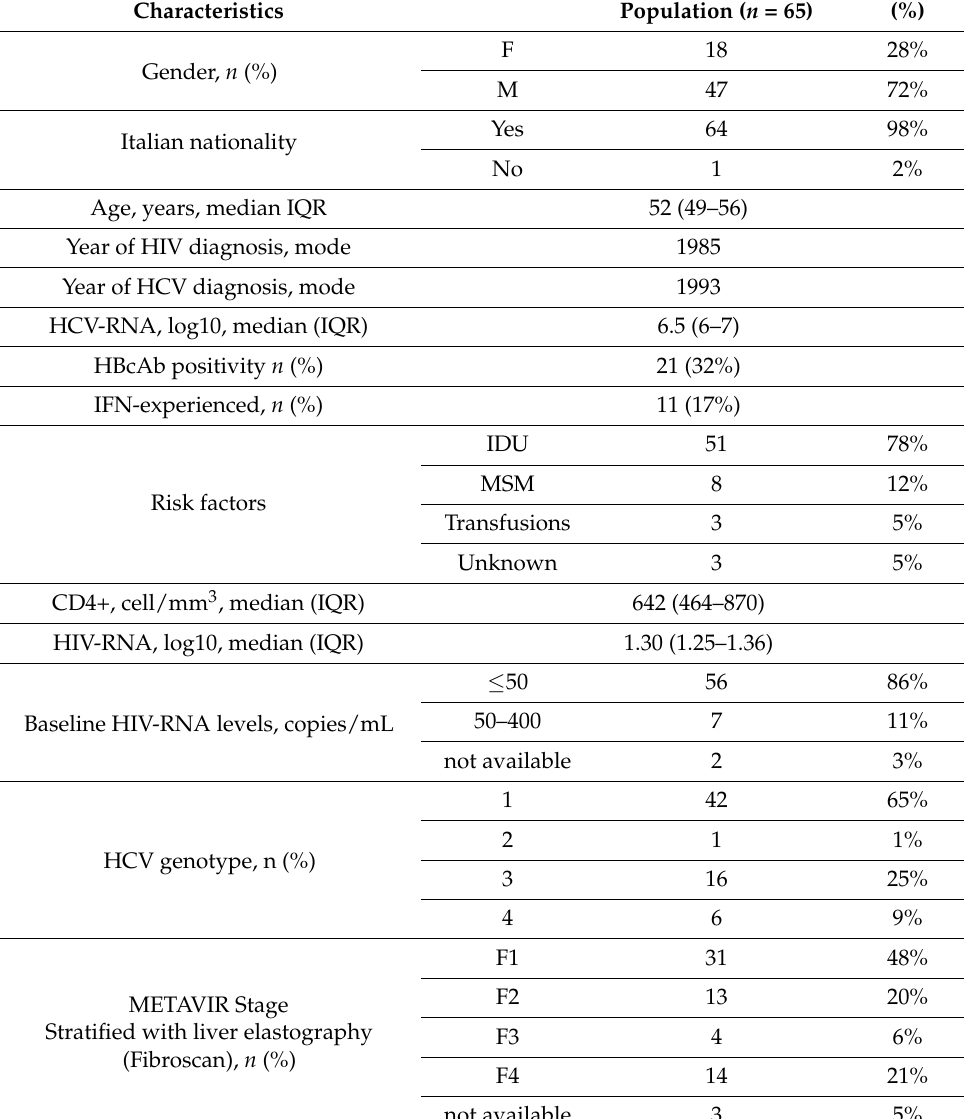
Table 1. Clinical and epidemiological characteristics of the whole